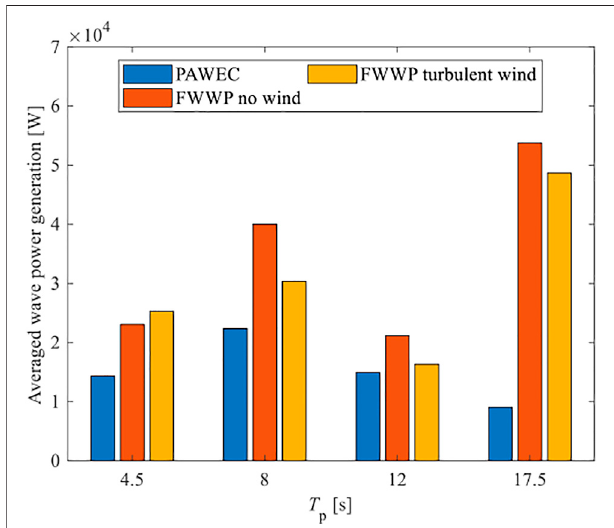
FIGURE17| AveragedwavepowergenerationforboththePAWECand